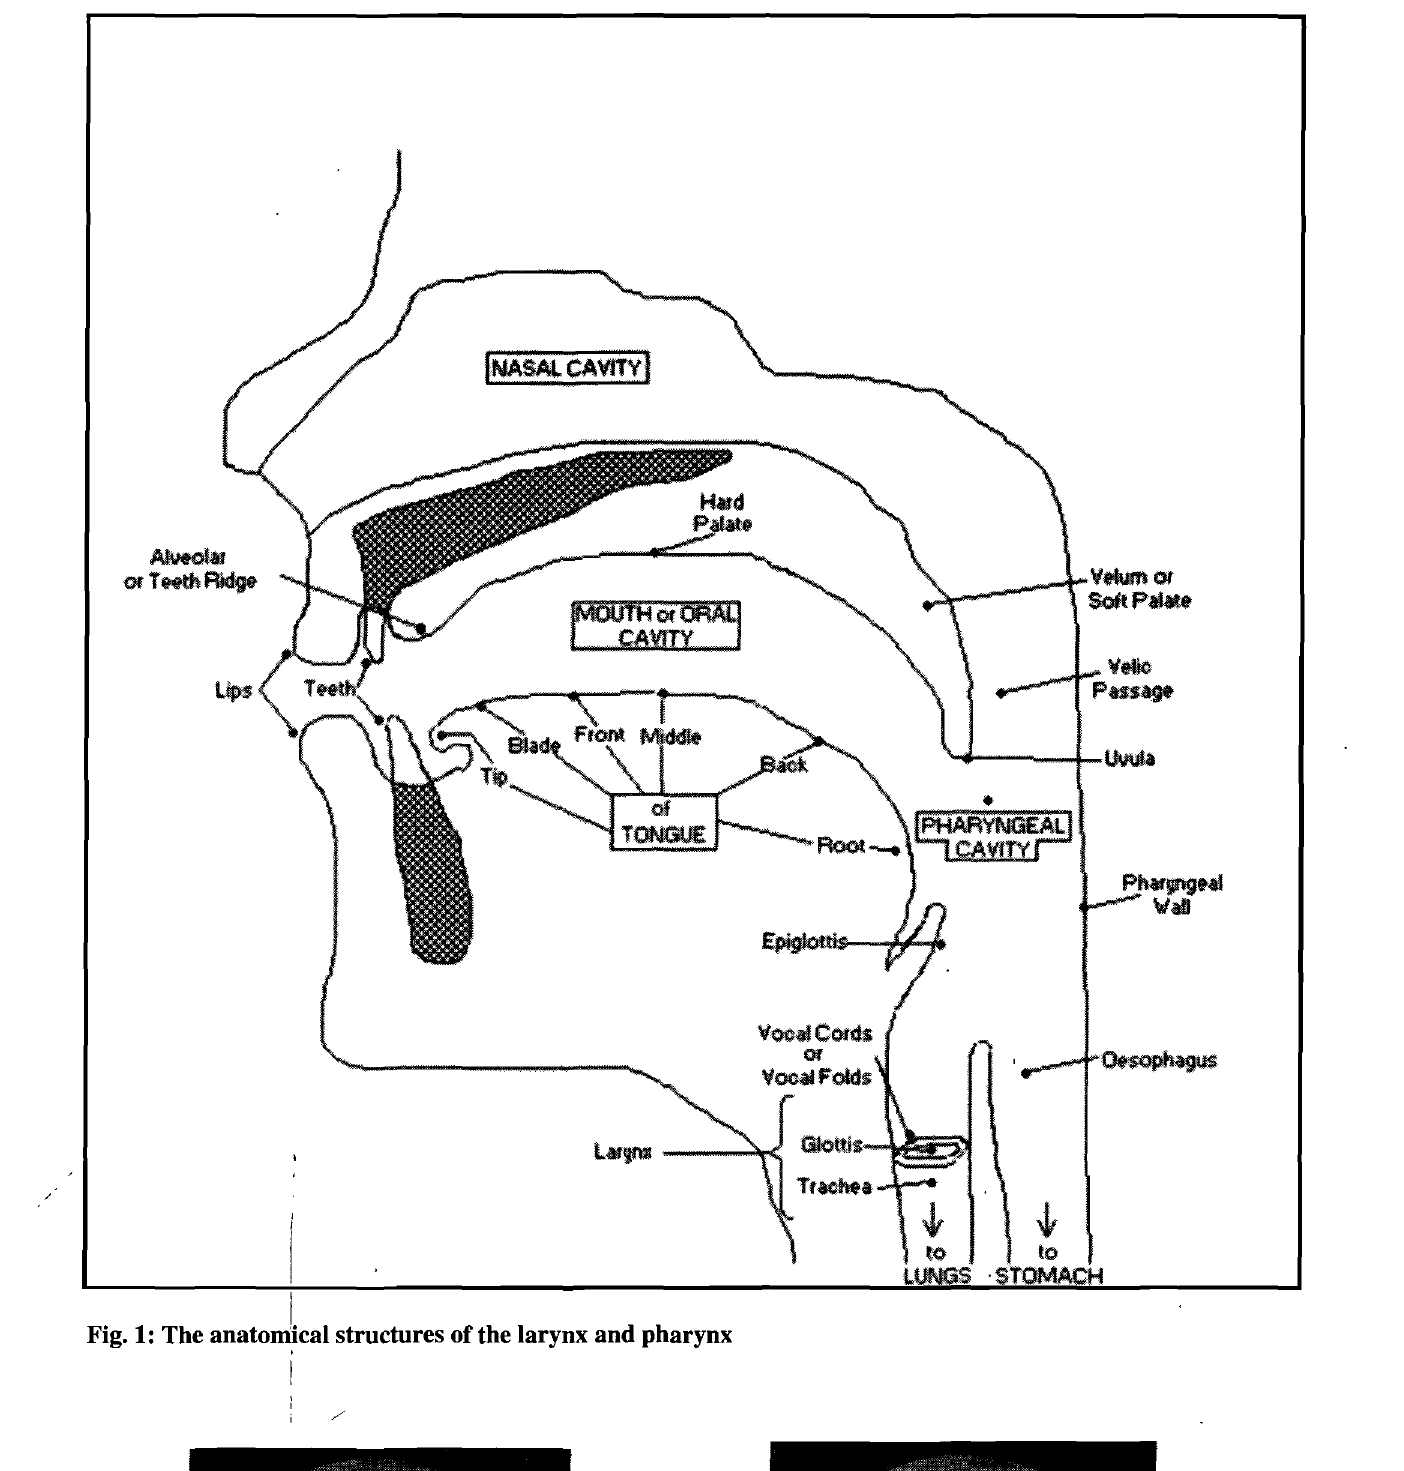
Fig. 1: The anlfltomi,cal structures of the larynx and pharynx